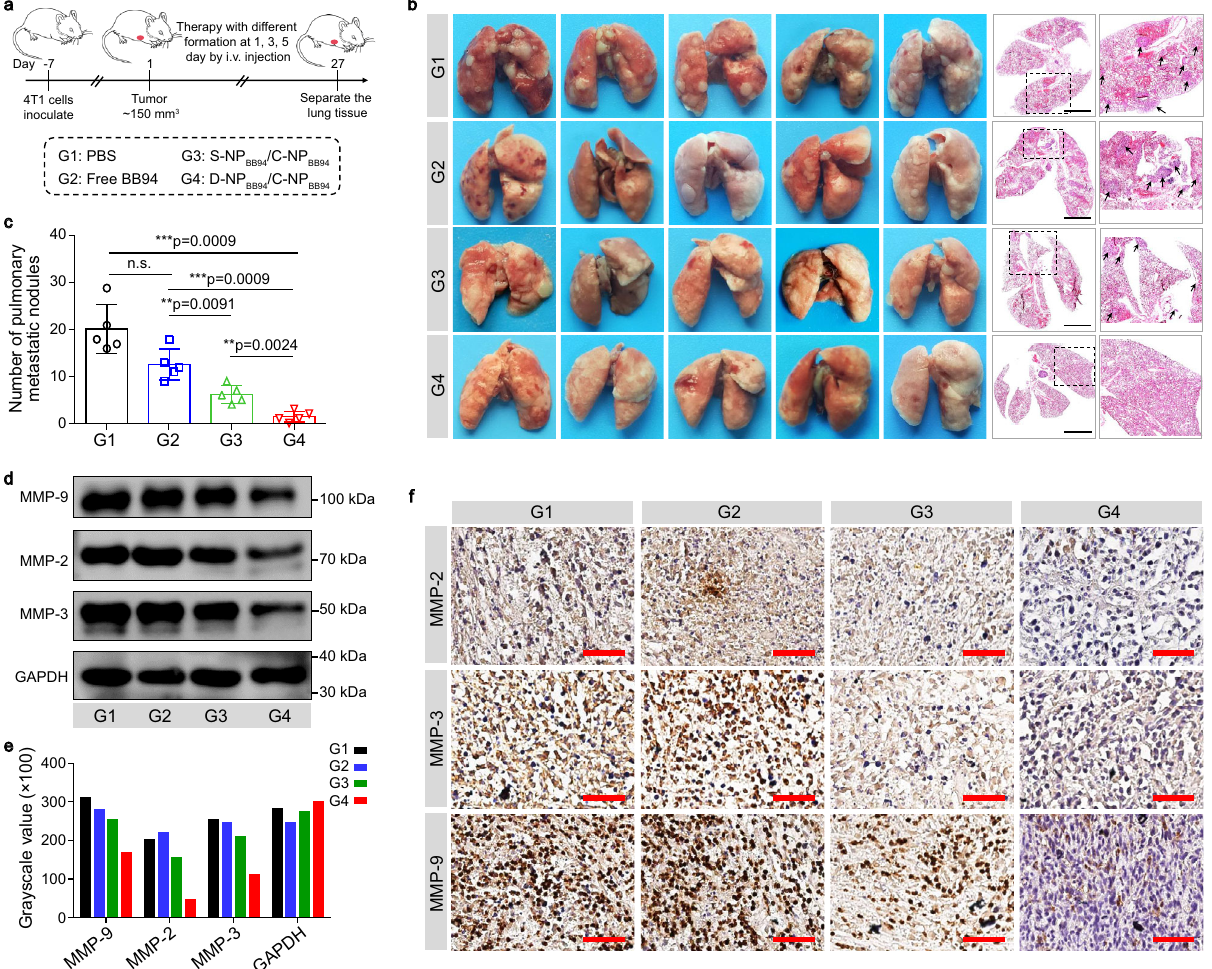
Fig. 4 The bioorthogonal in situ nanomedicine assembly enhanced the anticancer activity of BB94. a Schematic illustrating the experimental protocol for the orthotopic 4T1 breast tumor model. b Images and H&E staining of collected lung tissues at the end of treatment ( n = 5). Scale bar, 0.5 cm. c The number of metastatic lung nodules from mice bearing 4T1 tumors at the end of treatment. Data are presented as the mean ± s.d. ( n = 5). Statistical signi fi cance was calculated via Student ’ s t -test (two tail). ** p < 0.01, *** p < 0.001; n.s., no signi fi cant difference. d Immunoblot analysis of MMP-2, MMP-3, and MMP-9 in primary tumor tissue at the end of treatment. Experiments were repeated twice. e Statistical analysis of the stripe grayscale values in d . f Tumor immunohistochemical staining of MMP-2, MMP-3 and MMP-9 from primary tumor of each group at the end of treatment. Scale bar, 100 µ m. A representative image from one of fi ve independent fi elds of view in a single experiment. i.v.: intravenously, PBS: phosphate buffered saline, MMP: matrix metalloproteinase protease. Source data are provided as a Source Data fi